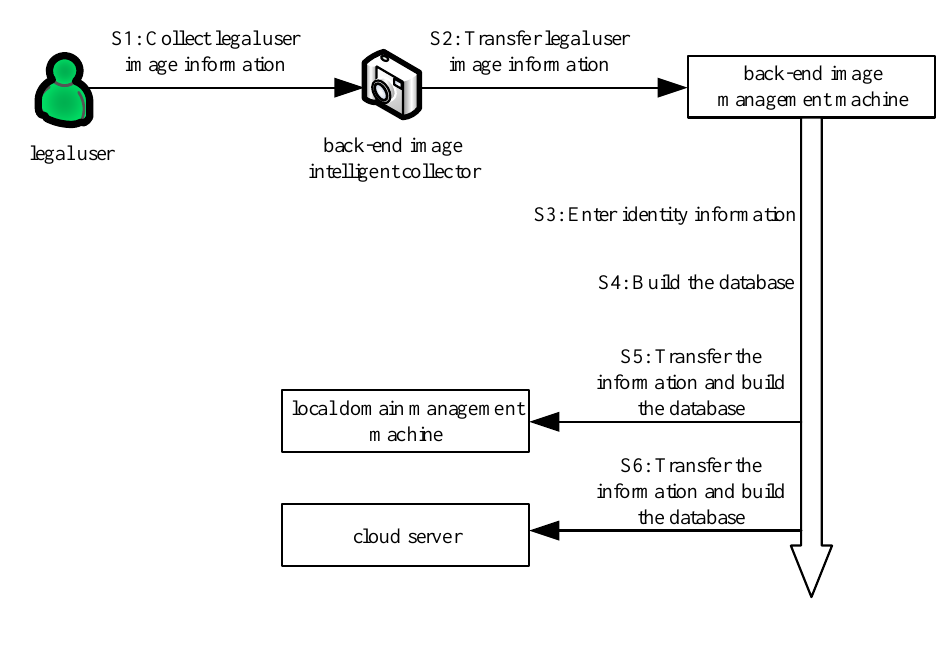
Figure 2. The system establishment phase’s brief process